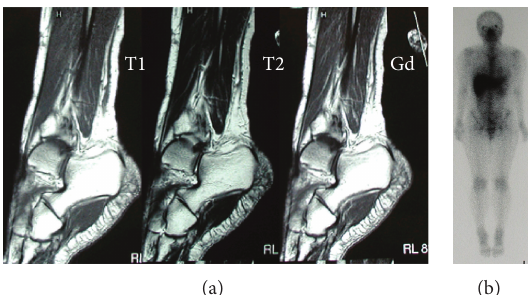
Figure 6: MRI (a) and bone scintigraphy (b) at 14 months after the surgery show no abnormal findings showing recurrence and local invasion of the